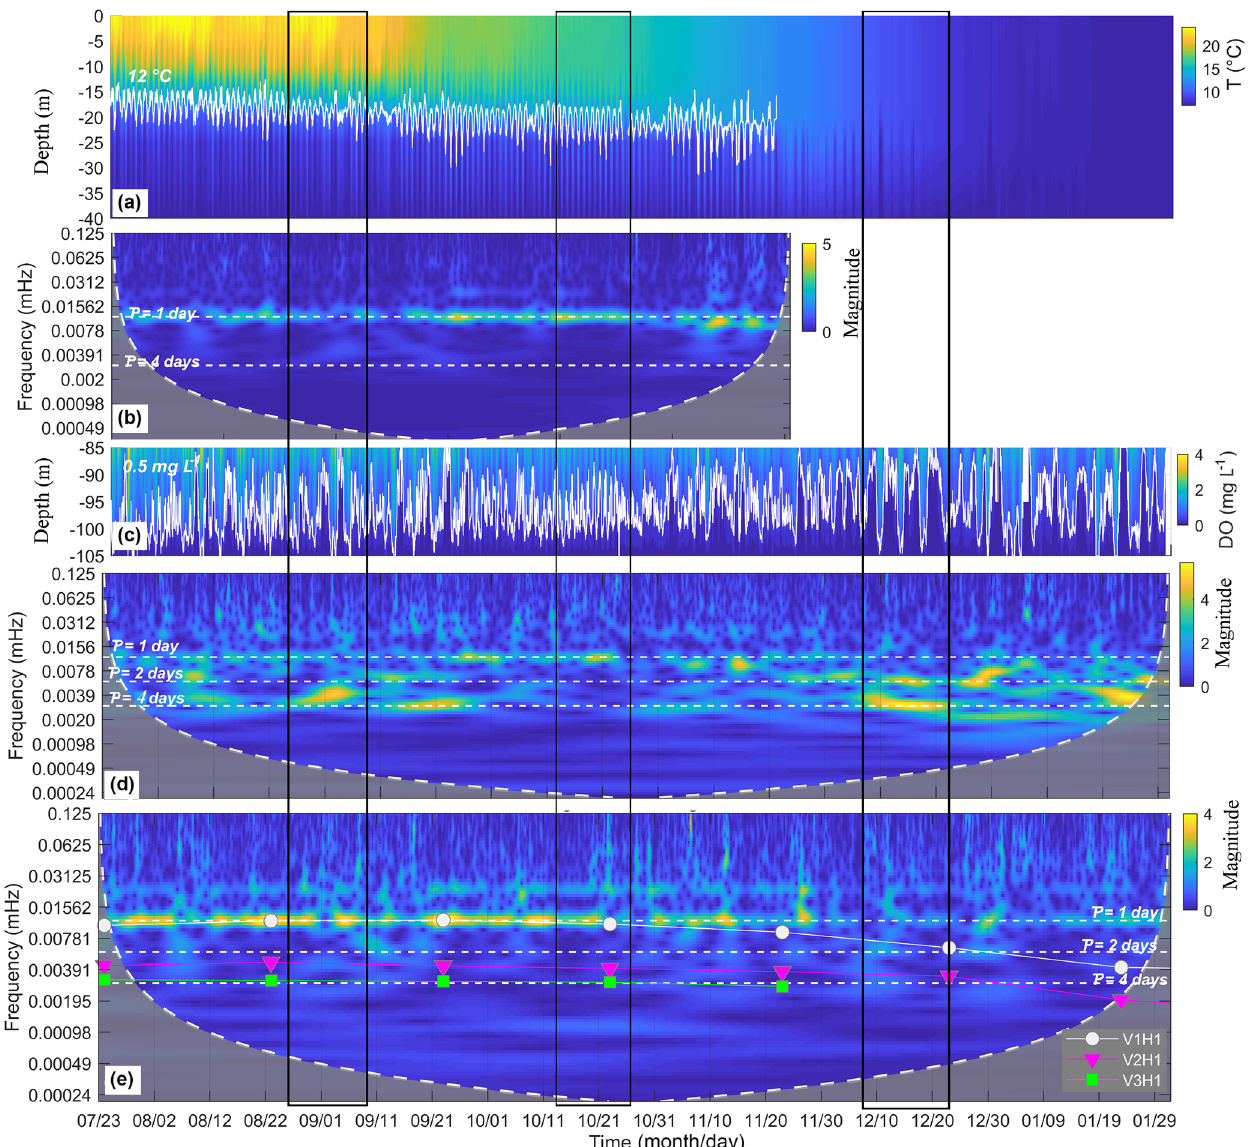
Figure 3. (a) Time series of the vertical displacements of the 12 ◦ C isotherm (white line) measured at LS-N, superimposed on the interpolated temperature distribution between 0 and 40m, and (b) the associated continuous wavelet transform for the period between 23 July and 21 November 2017. (c) Time series of the vertical displacements of the 0.5mgDOL − 1 isoline measured at LS-S, superimposed on the interpolated distribution of oxygen, and (d) the associated continuous wavelet transform. (e) Natural periods of the V1H1, V2H1 and V3H1 modes superimposed on the continuous wavelet transform of the N–S component of the wind measured at LS-N. The grey shaded regions on either end indicate the cone of influence, in which edge effects become important. The three rectangles with a black outline show the three periods analyzed in the following Figs.